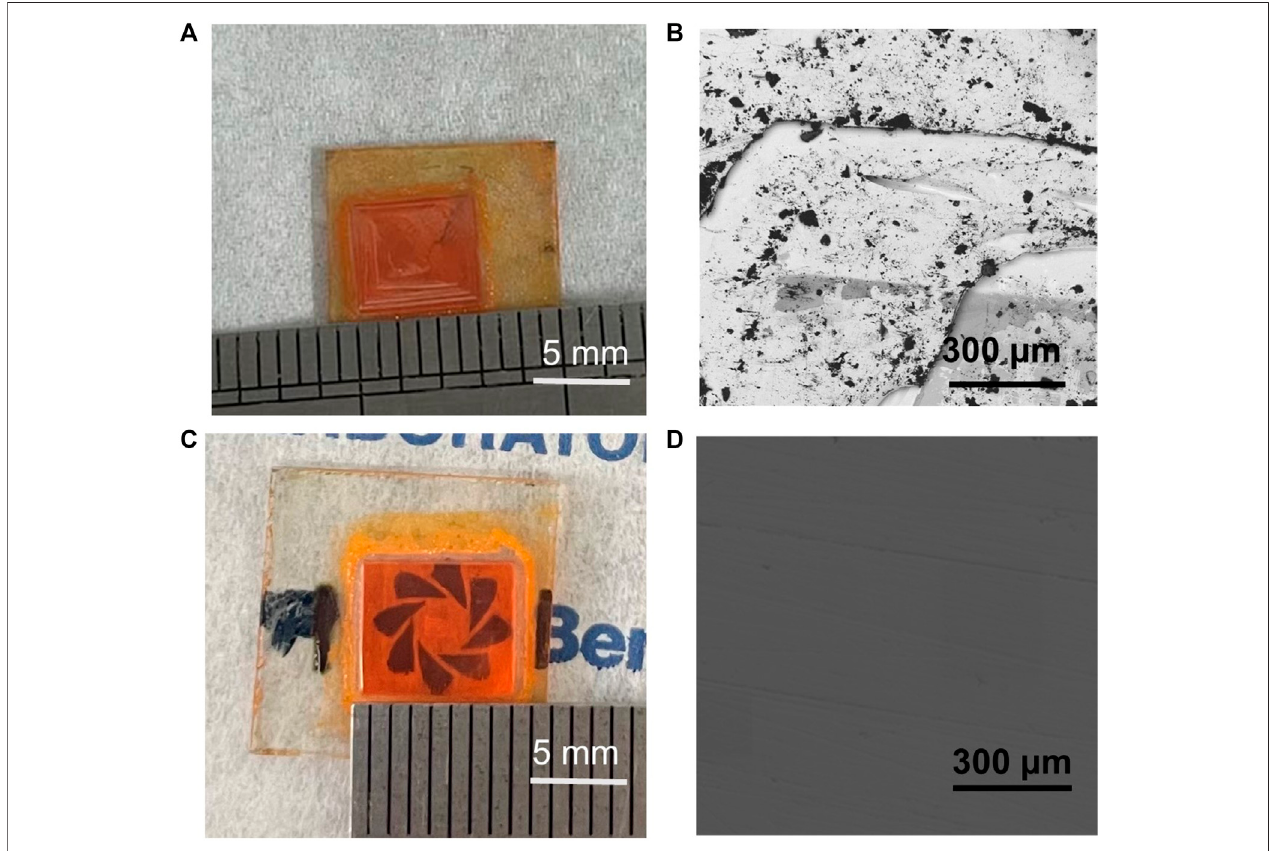
FIGURE 3 | (A) – (B) Photograph and top view SEM of the as-grown single crystal. (C) – (D) Photograph and top view SEM of the polished single